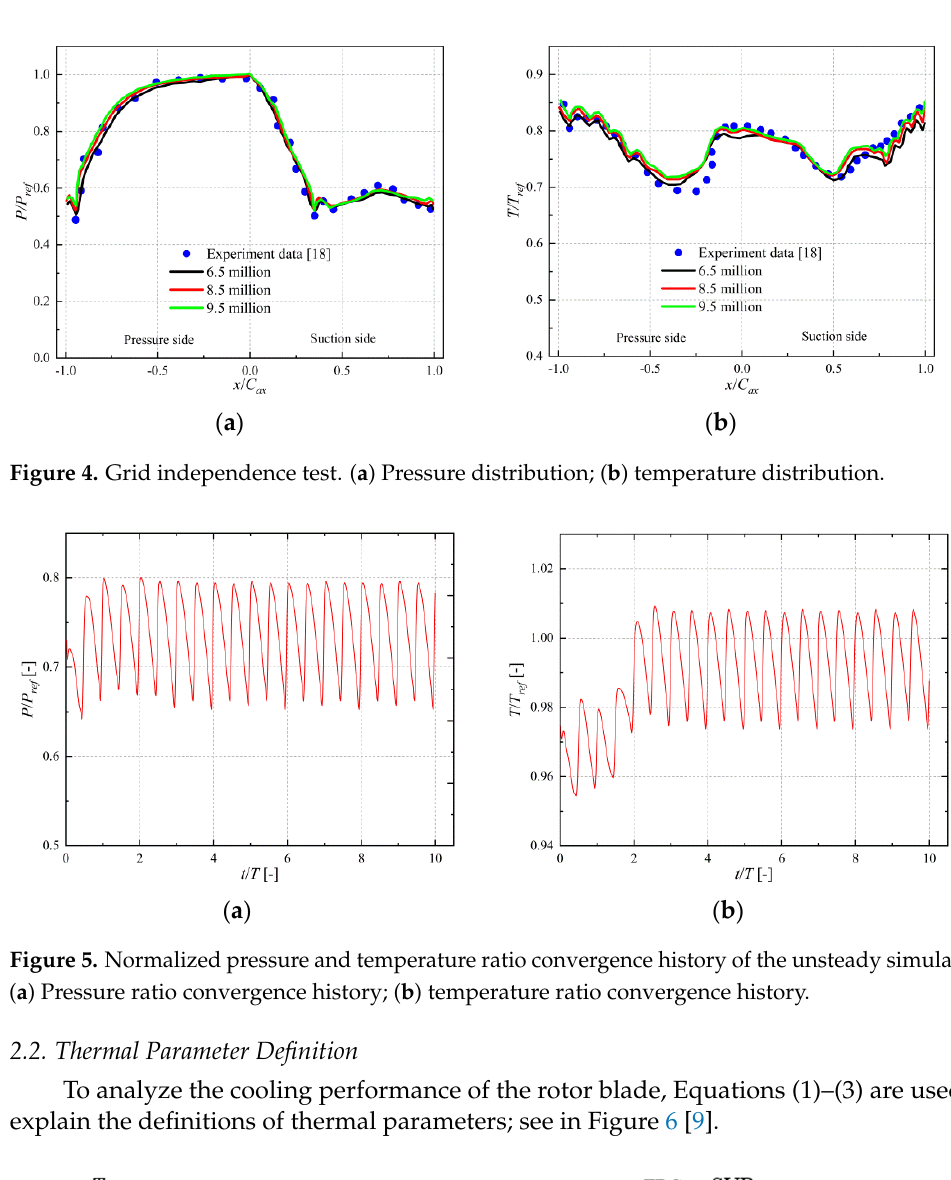
Figure 3. Temperature distribution of the turbine stage. ( a ) Temperature distribution; ( b ) tempera- ture profile.